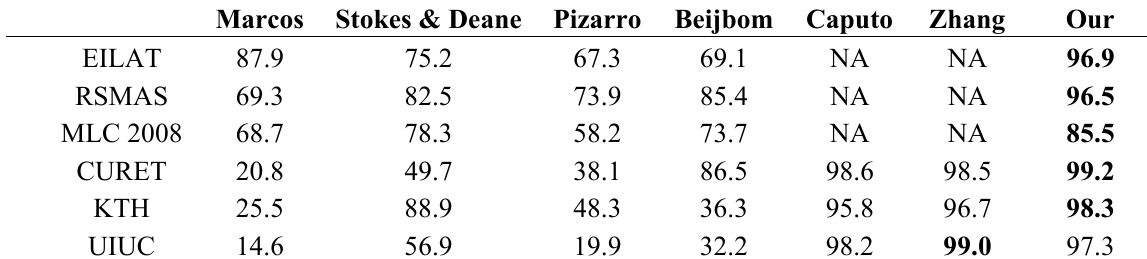
Table 11 . Overall accuracy (OA) (%) for each method/dataset. The highest overall accuracy obtained for each dataset is shown in bold.